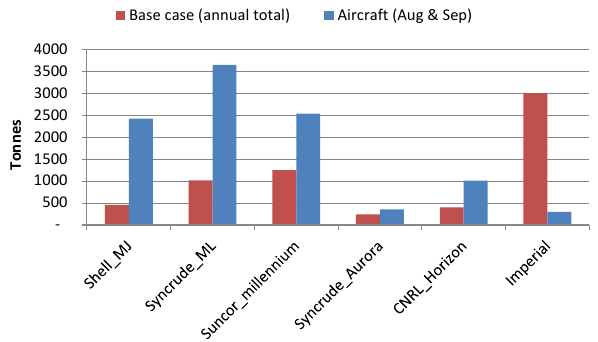
Figure 9. Comparison of PM 2 . 5 emissions between base-case an- nual emissions and aircraft-observation-based estimates for the 2 summer months (August and September) for the six AOSR mining